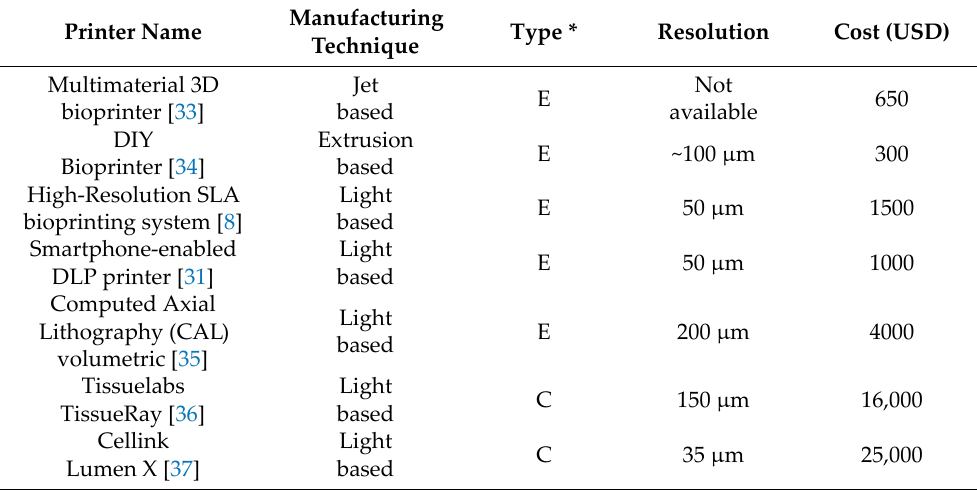
Table 1. Bioprinting equipment. Examples of 3D bioprinting equipment, technique, resolution, and costs. Adapted from [32].